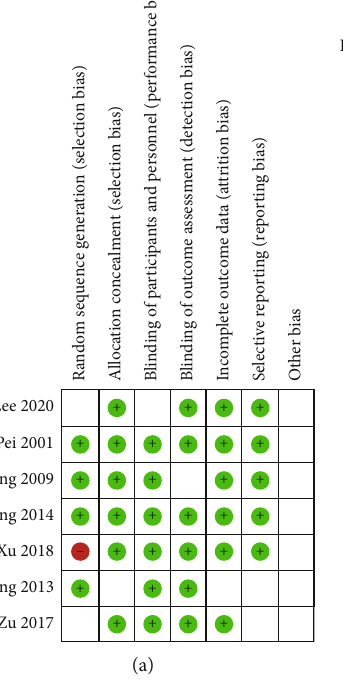
Figure 2: Characteristics of included studies. Risk of bias summary (a). Risk of bias graph